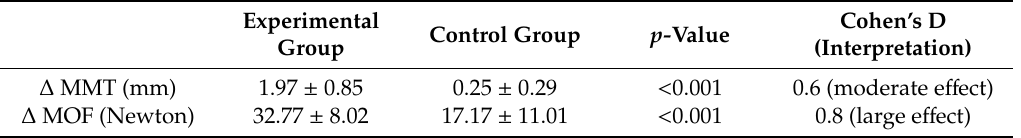
Table 4. Comparison of amount of change in each group. Experimental Control Group p- Value Group ∆ MMT